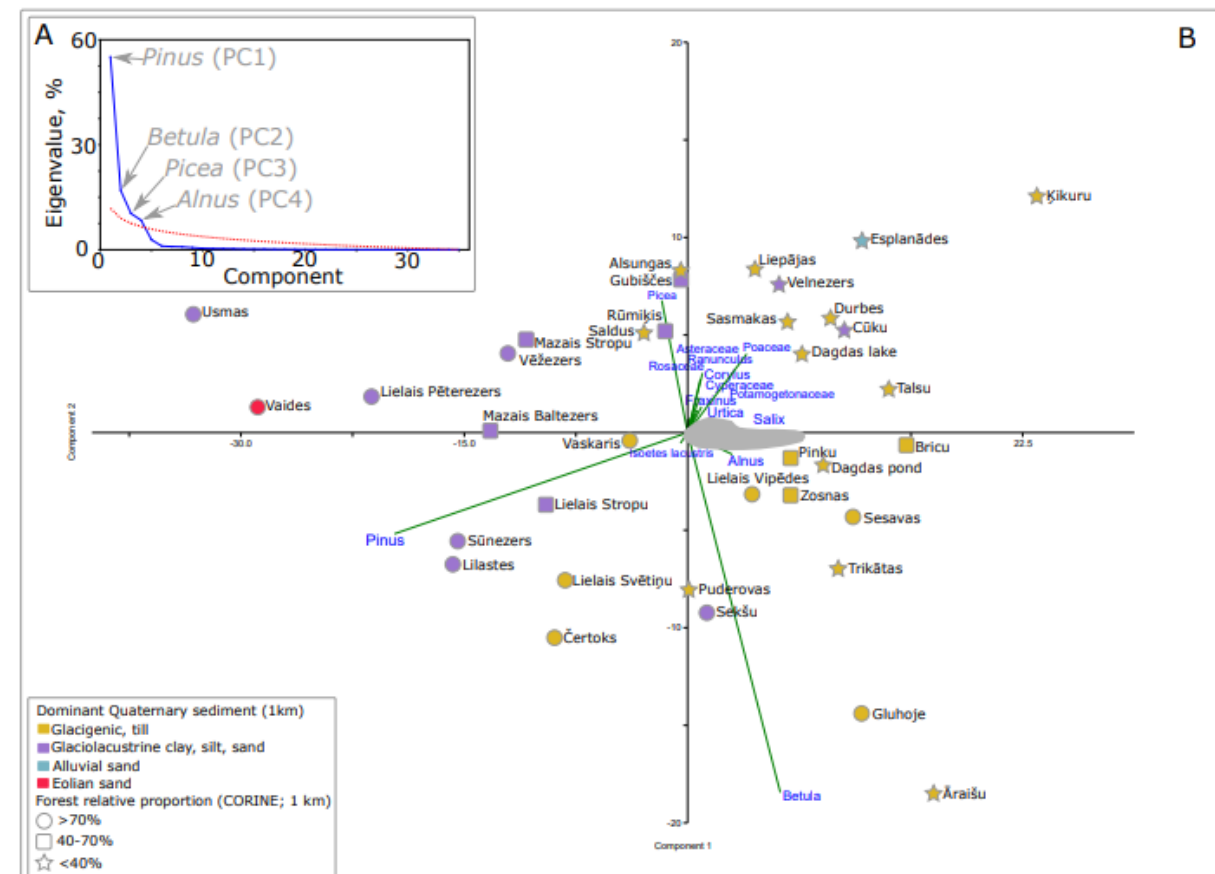
Figure 5. Principal component analyses of modern pollen in waterbodies with ( A ) Eigenvalues of first four significant principal components and the strongest associations, and ( B ) over all pollen dispersal and distribution between sites indicating both dominant Quaternary sediment and the relative forest share (CORINE) within 1 km radius around the waterbodies. Gray elongated area shows the location of pollen taxa that were indistinguishable and do not have a strong influence on the first axes .